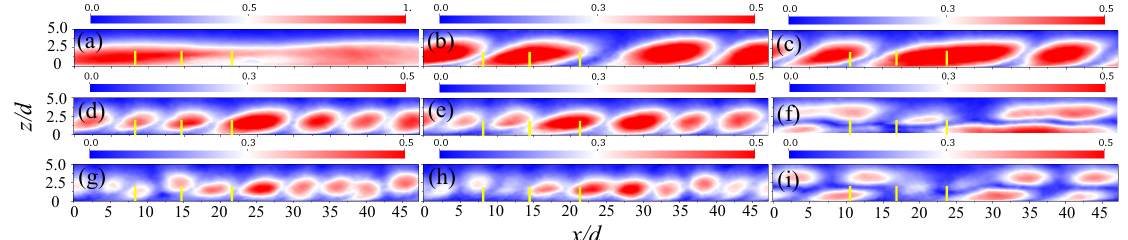
Figure 15. Normalized Fourier-POD mode for wave-number, k y d = 0.8. ( a ) m = 0, ( b ) m = 1, ( c ) m = 2, ( d ) m = 3, ( e ) m = 4, ( f ) m = 5, ( g ) m = 6, ( h ) m = 7, ( i ) m = 8. Red-blue contours indicate the normalized velocity magnitude modes,